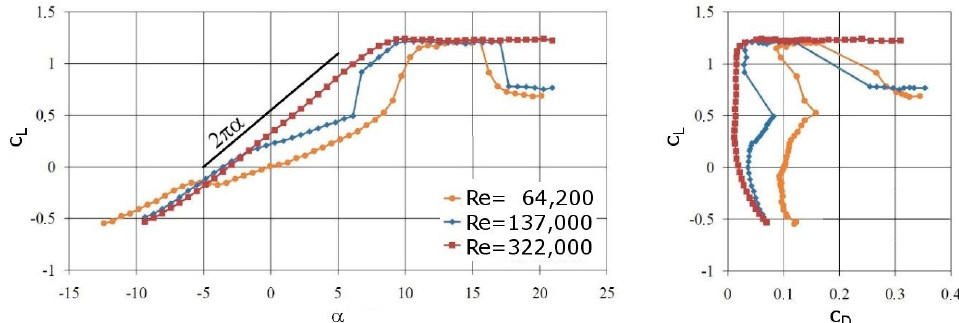
Figure 13. Lift curves and 2 π slope of thin airfoil theory as well as drag polars. (Reprinted from [29]).